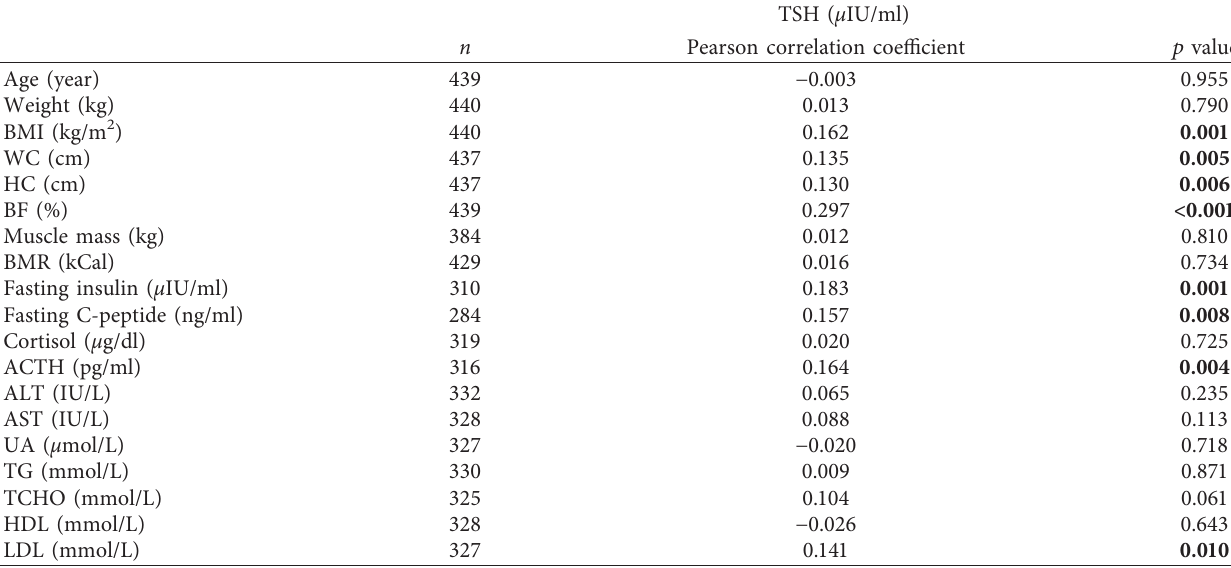
Table 5: Correlation of demographic characteristics, body composition, and metabolic indicators with TSH in overweight and obese